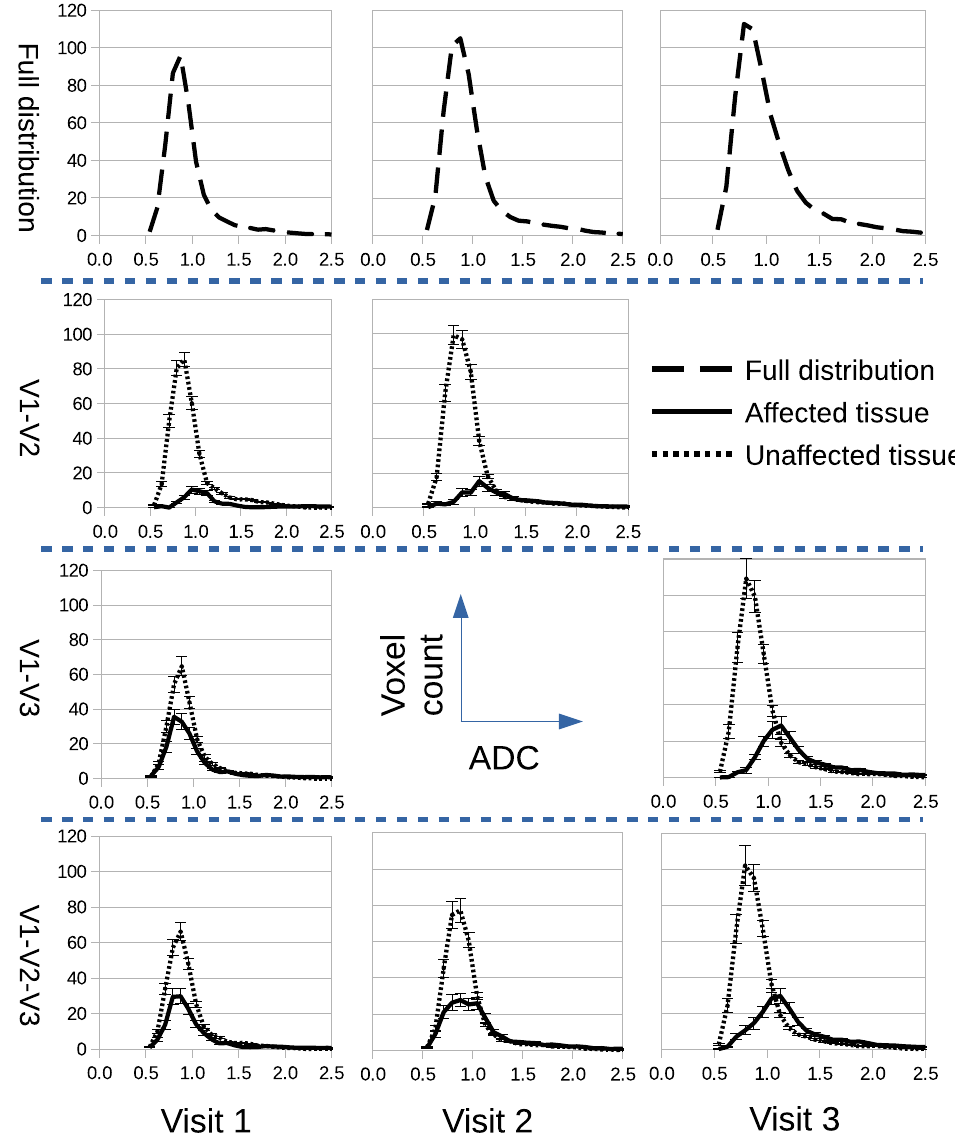
Figure 4. LPM decomposes ADC distributions into treatment-affected parts and parts that have no measurable differences from control distributions (unaffected). Rows from top to bottom show the full ADC distributions before decomposition, followed by alternative decomposition models for scan combinations V1–V2, V1–V3, and